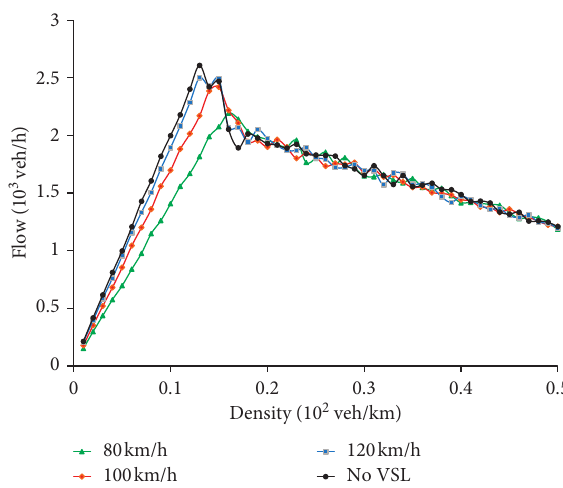
Figure 3: Fundamental diagram of different speed limit values for single-lane cellular automaton model simulation.